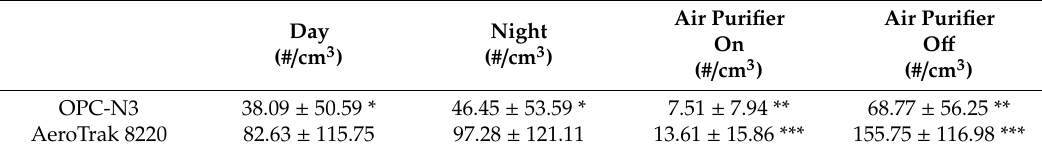
Table 1. The mean PN concentrations were recorded with OPC-N3 and AeroTrak8220 sensors. The asterisks (*) denote the pairs with a statistically significant di ff erence confirmed with a two-sample t -test at the 95% confidence level. Only the pair day–night recorded with the AeroTrak8220 instrument did not reveal a statistically significant di ff erence of the mean. The day and night data include the air purifier on or o ff periods and vice